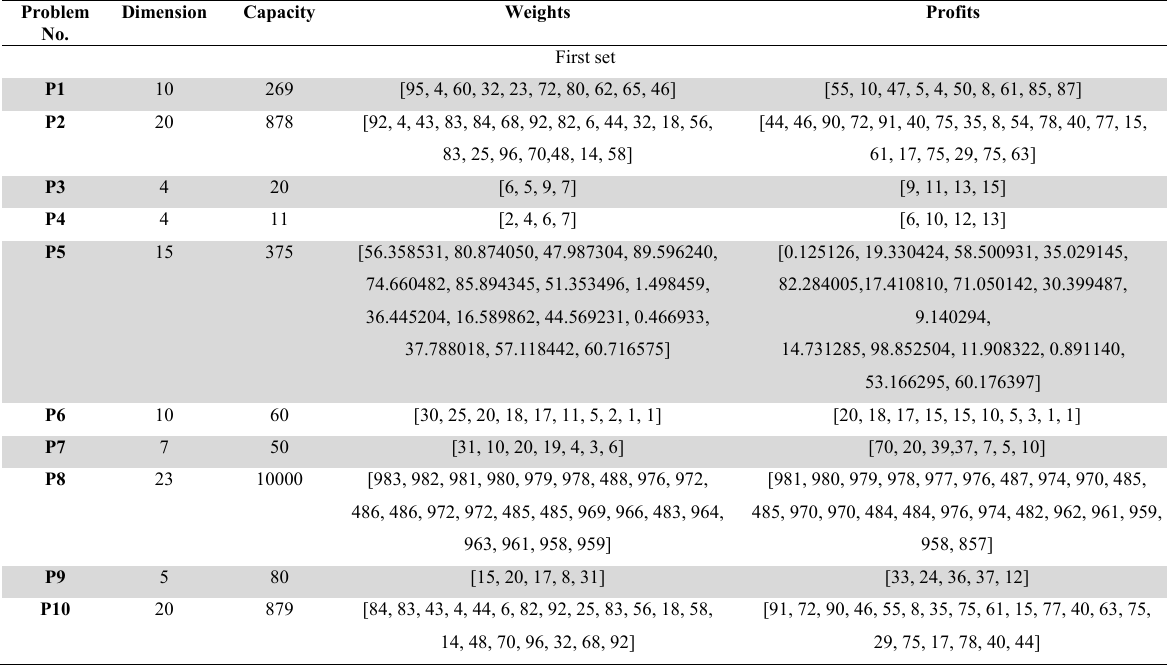
List of small-scale 0-1 knapsack problems Problem No.